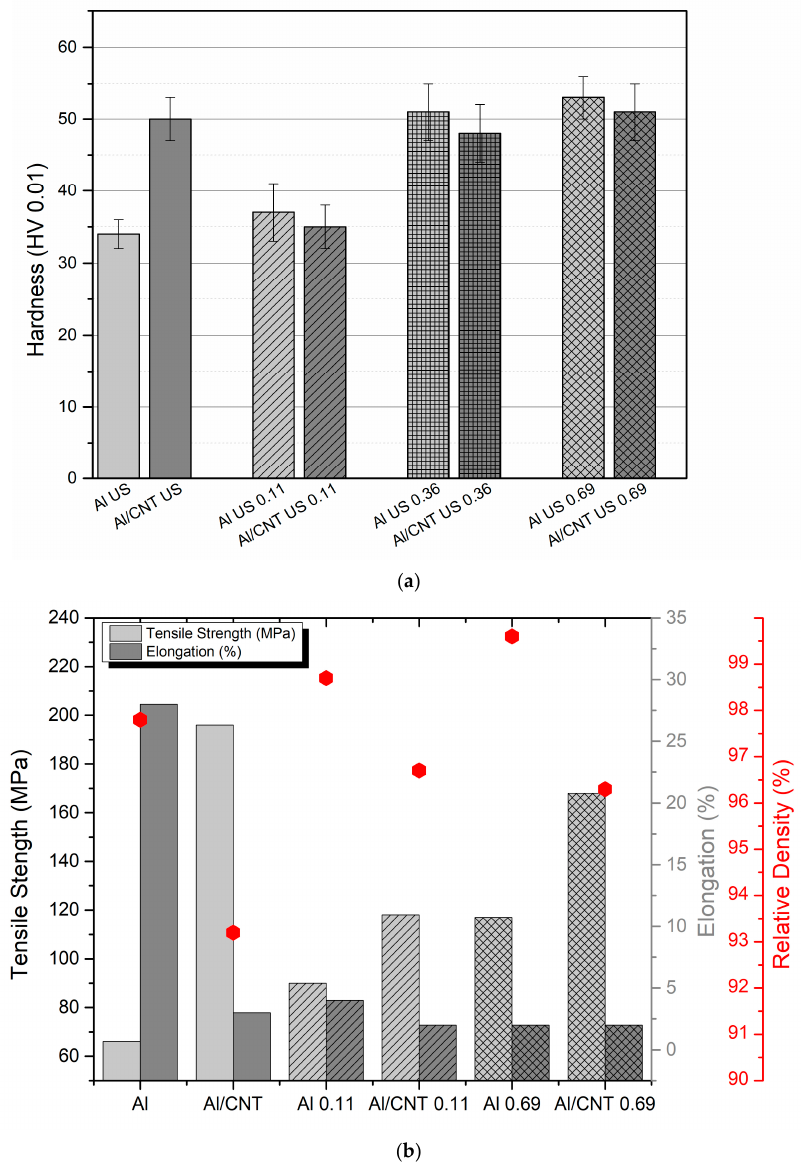
Figure 4. ( a ) Vickers microhardness and ( b ) tensile strength, elongation, and density for the Al/CNTs nanocomposites and Al matrix as-sintered and cold rolled up to different strain values. The different column grid represents di ff erent applied strains.